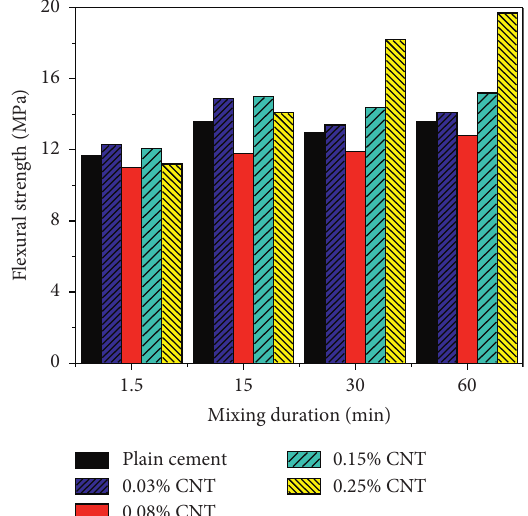
Figure 18: Effect of the mixing time on the flexural strength of CNT cement composites